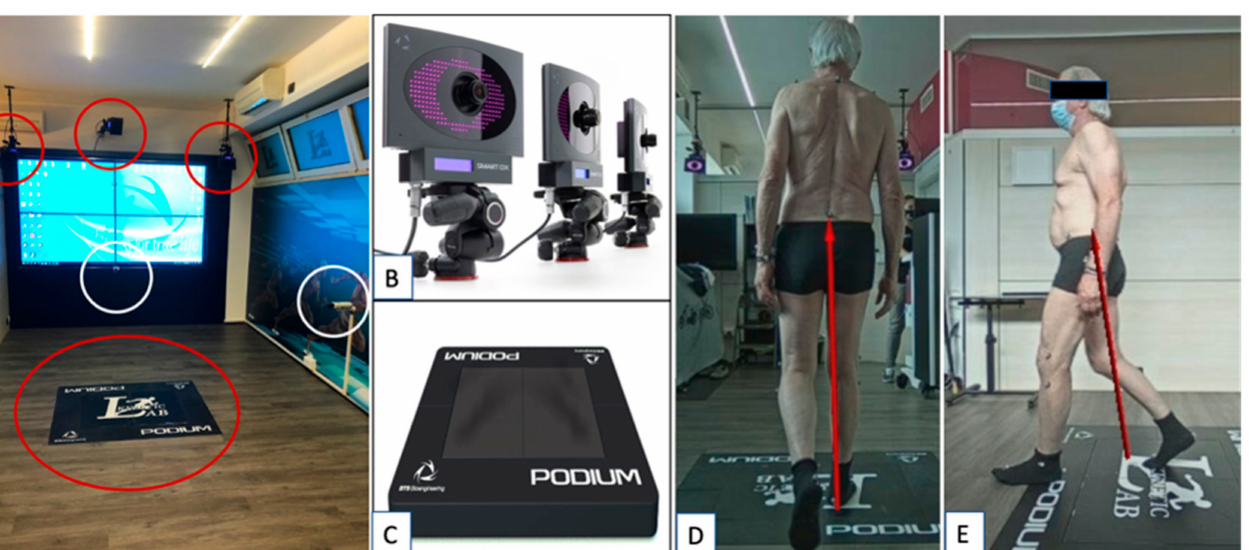
Figure 1. The first measurement detected with the trial components did not result in an optimal balance: the medial compartment was too tight while the lateral one was too loose ( A ). The surgeon tried to achieve the right balance between medial and later compartment by performing a release of the medial compartment using the “pie crust” technique ( B ). The ligament tension detected after the medial release has been considered satisfying, with an equal forces distribution among the two compartments of the knee ( C ). In a severe varus or valgus knee, according to measured resection, a medial or lateral ligamentous release can be performed to obtain a better balance: the “pie crust” technique consists of performing small cuts in the too tight structures using an 18-gauge needle or a n. 11 scalpel blade ( D ).